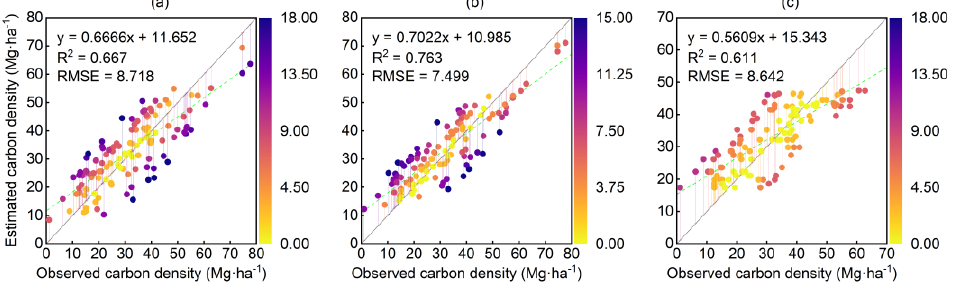
Figure 4. Carbon density estimation and validation for linear regression ( a ), random forest regression ( b ), and allometric growth curve fitting( c ).